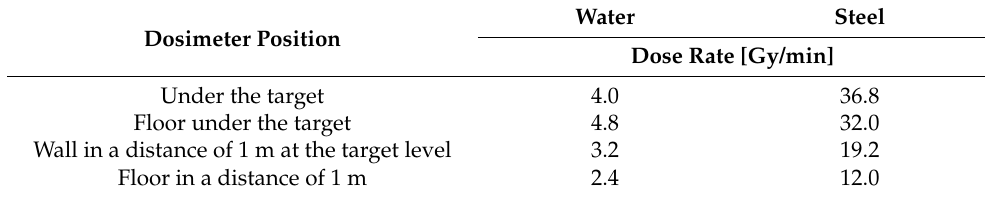
Table 2. Dependence of the dose rate on the distance from the accelerator window and the target material. Dosimeter